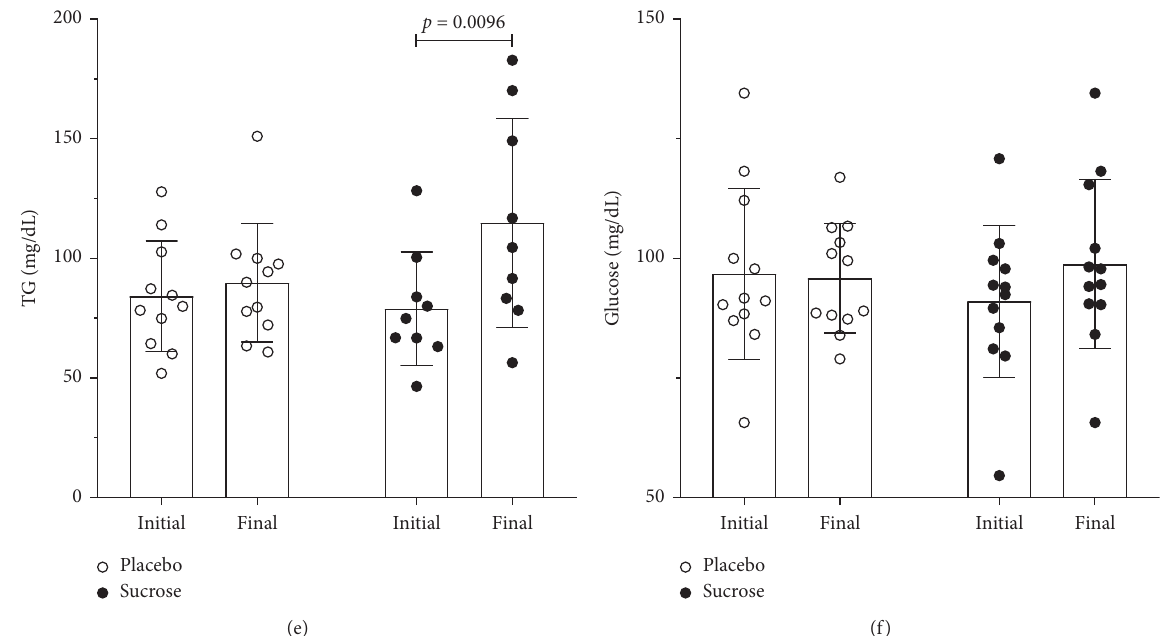
Figure 2: Anthropometric, body composition, and metabolic parameters. (a) Weight, 95% CI of the difference between initial vs. final ( − 0.7009 to 0.1368), no differences, 95% CI of the difference between placebo vs. sucrose ( − 9.710 to 9.534), p � 0 . 0002 (Bonferroni’s multiple comparisons test), n � 17. (b) BMI � body mass index, 95% CI of the difference between initial vs. final ( − 0.3136 to 0.04690), no differences, 95% CI of the difference between placebo vs. sucrose − 3.481 to 3.368), p � 0 . 0016 (Bonferroni’s multiple comparisons test), n � 12. (c) WC � waist circumference, 95% CI of the difference between initial vs. final ( − 0.9632 to 0.1474), no differences, 95% CI of the difference between placebo vs. sucrose ( − 9.742 to 9.393), p � 0 . 0017 (Bonferroni’s multiple comparisons test), n � 12. (d) VLDL � very-low-density lipoproteins, 95% CI of the difference between initial vs. final ( − 6.872 to − 0.3415), no differences, 95% CI of the difference between placebo vs. sucrose ( − 12.15 to 1.796), p � 0 . 0281 (Bonferroni’s multiple comparisons test), n � 10. (e) TG � triglycerides, 95% CI of the difference between initial vs. final ( − 36.55 to − 4.970), no differences, 95% CI of the difference between placebo vs. sucrose ( − 32.73 to 13.07), p � 0 . 0096 (Bonferroni’s multiple comparisons test), n � 10. (f) Glucose, 95% CI of the difference between initial vs. final ( − 11.76 to 4.957), no differences, 95% CI of the difference between placebo vs. sucrose ( − 9.202 to 11.93), no differences (Bonferroni’s multiple comparisons test), n � 12; two-way repeated measure ANOVA followed by Bonferroni’s multiple comparisons